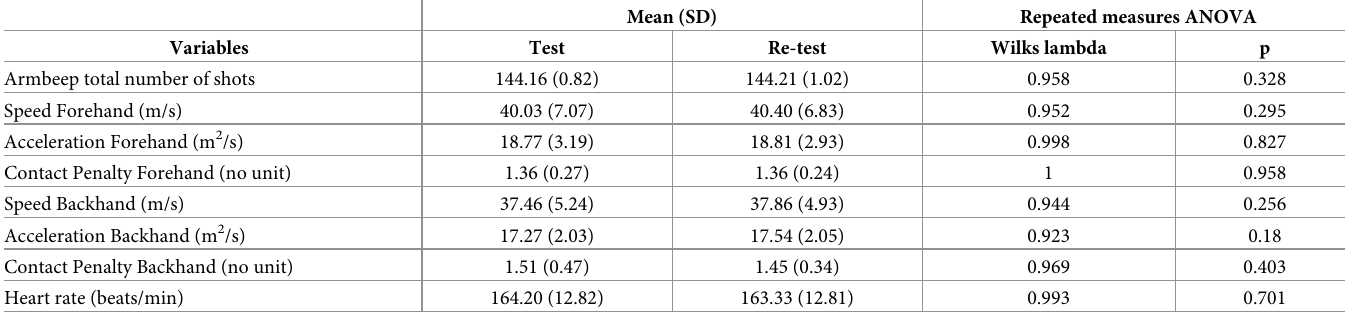
Table 2. Repeated measures ANOVA for test and re-test measurements with Armbeep sensor.